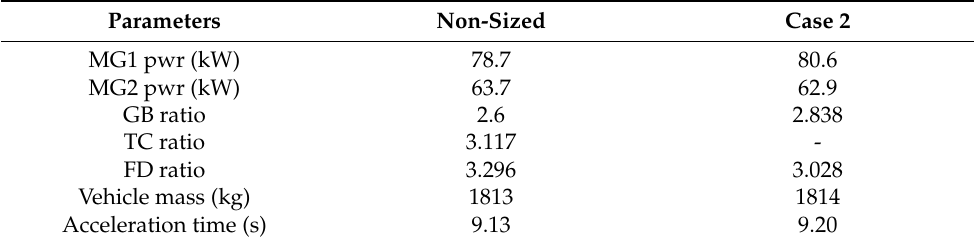
Figure 7. Results on entire range versus GB and FD and feasible points: ( a ) acceleration results; and ( b ) fuel consumption results. Table 5. Component-sizing results and acceleration performance for Case